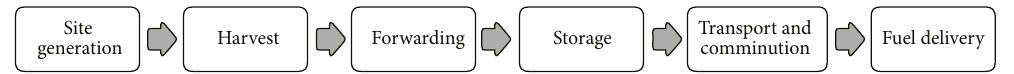
Figure 1: Model and process structure in the proposed supply chain simulation model with the different submodules included.